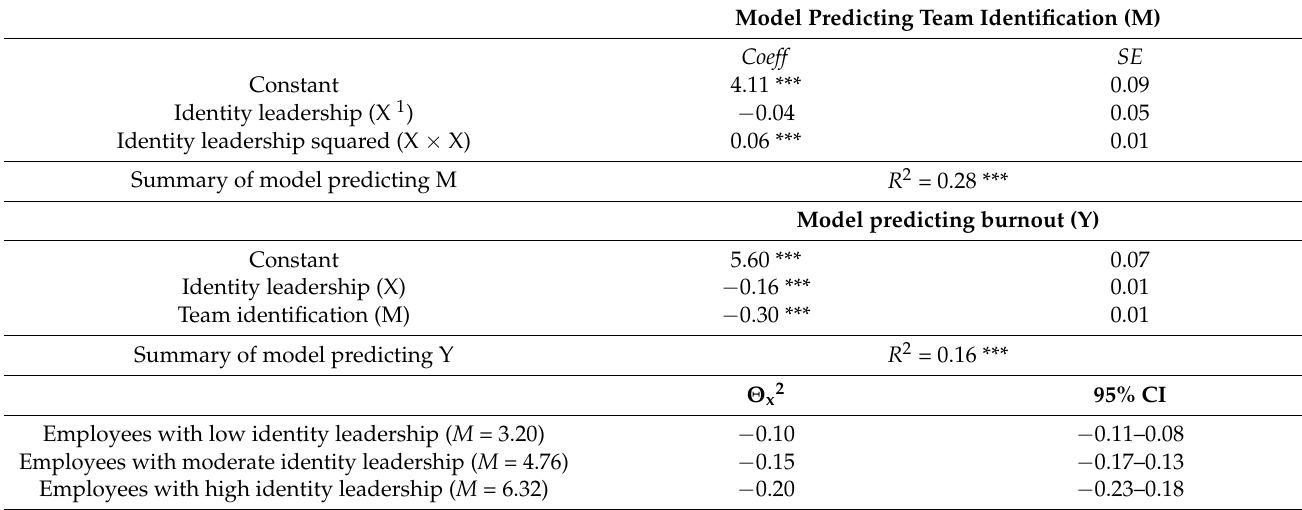
Table 6. Indirect effect of X on Y through M, with a non-linear relation between X and